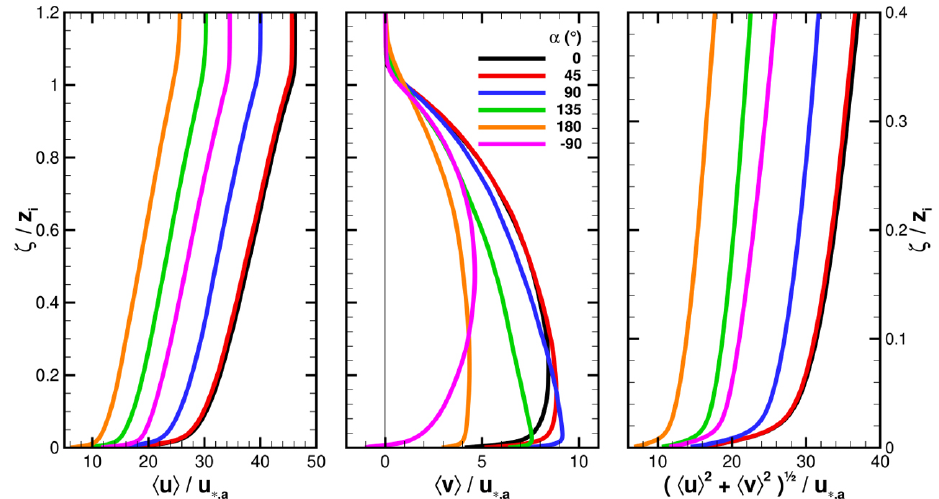
Figure 3. Impacts of various wave propagation directions relative to the mean wind direction on wind components throughout the ABL depth, from wave-resolving atmospheric LES (Patton et al., 2019). Note that 0 ◦ denotes that the wind direction is aligned with the wave propagation direction. The difference in the wind profiles for the 90 and − 90 ◦ is due to Coriolis force.